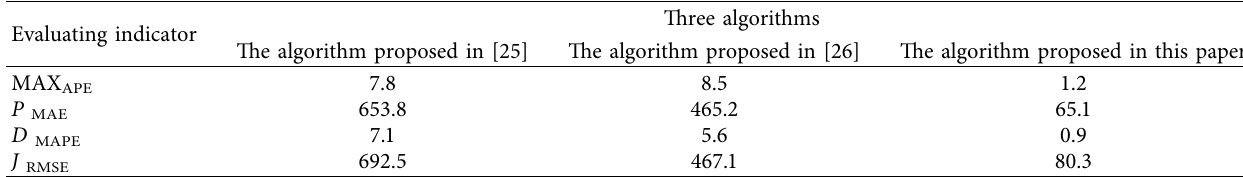
Table 5: Comparison of test indexes of different